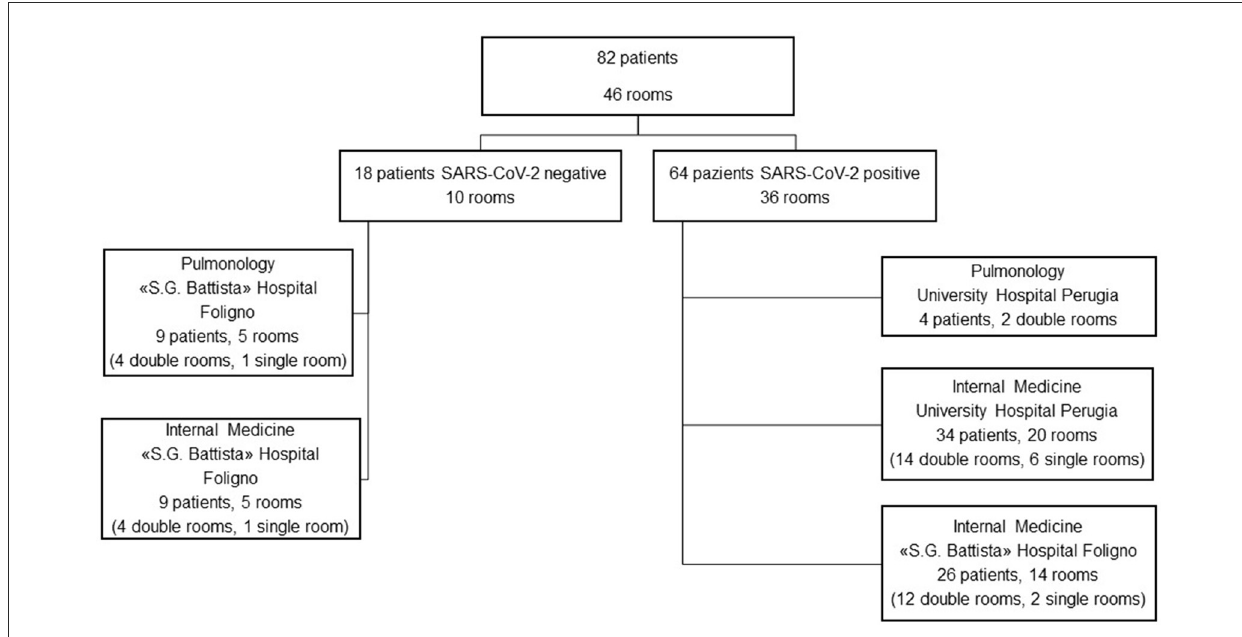
FIGURE1 Flow-chart of the study design.